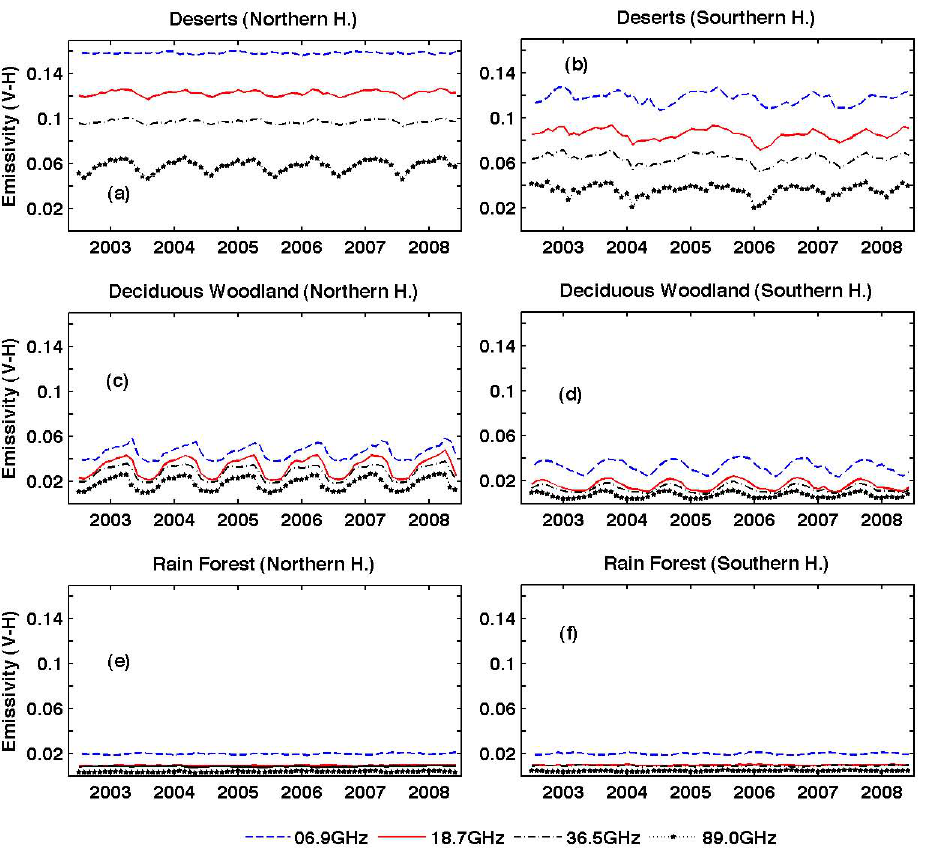
Fig. 4. Seasonal variation of the vertical and horizontal polarization differences at 6.9, 18.7, 36.5, and 89.0GHz in (a, b) desert regions (c, d) deciduous woodland (e, f) rain forest (Matthew’s vegetation classification (Matthews, 1983) for Northern and Southern